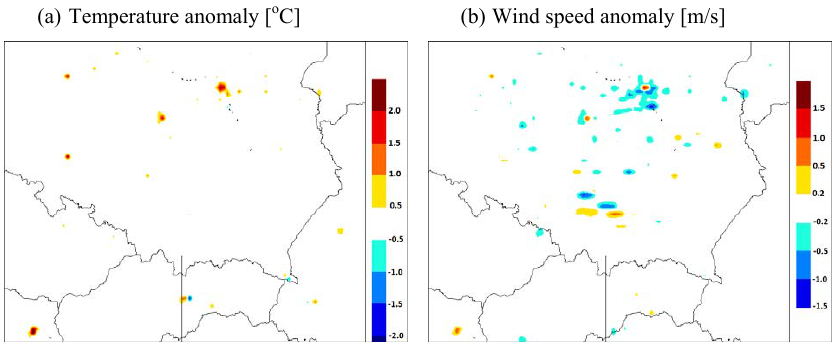
Figure 12. Temperature (a) and wind speed (b) anomaly calculated as the difference between urban and non-urban scenarios – 29 March 2011, 18:00UTC.